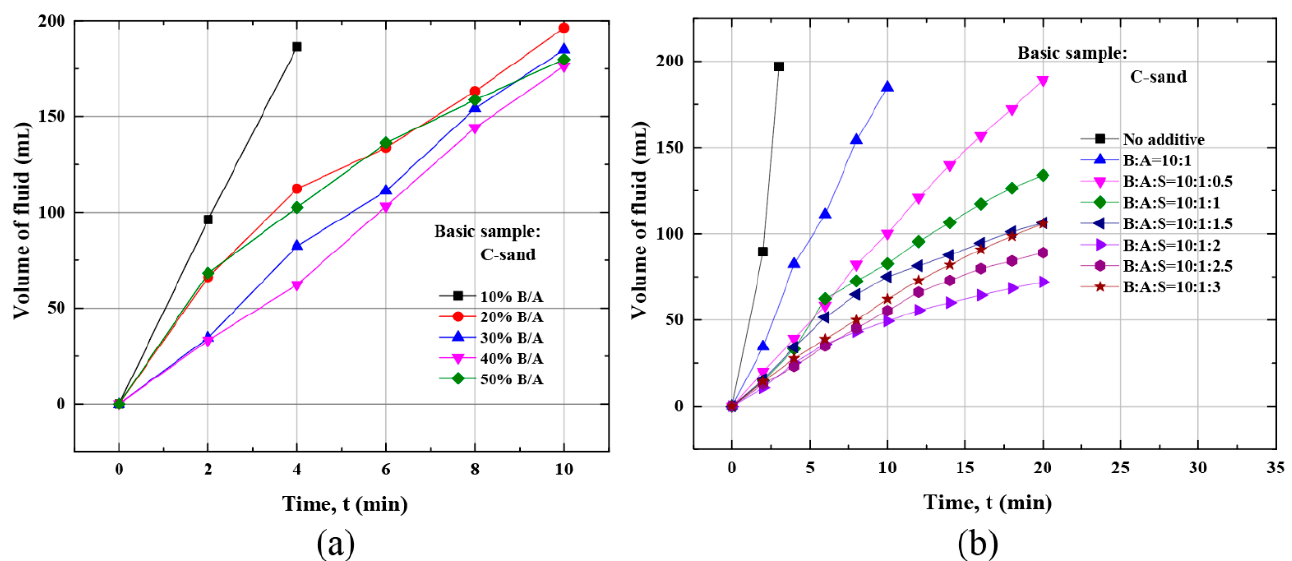
Figure 7. ( a ) Effect of B/A injection ratio on seepage flow. ( b ) Effect of sodium silicate content on B/A seepage flow.